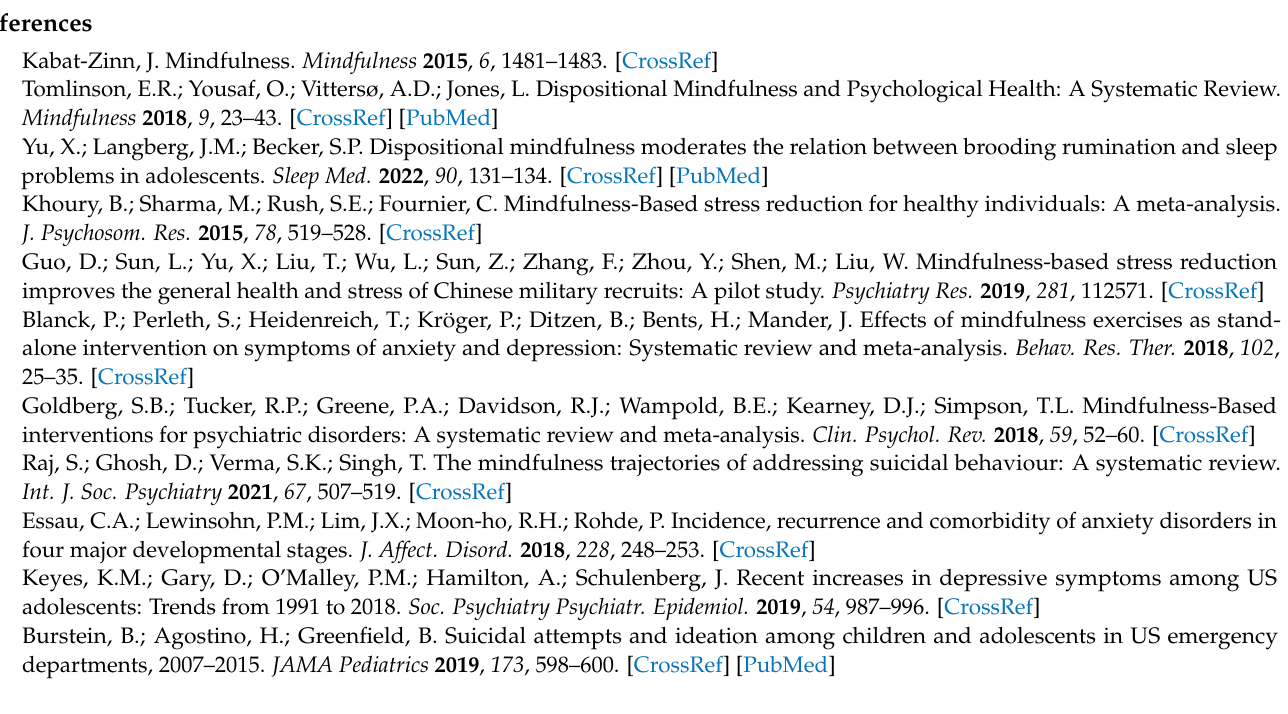
Figure A3. Scatterplot of significant correlations between parameter estimate (Focus-on-Breath vs. Describe) in insula subregions during neurofeedback runs and PROMIS measures.